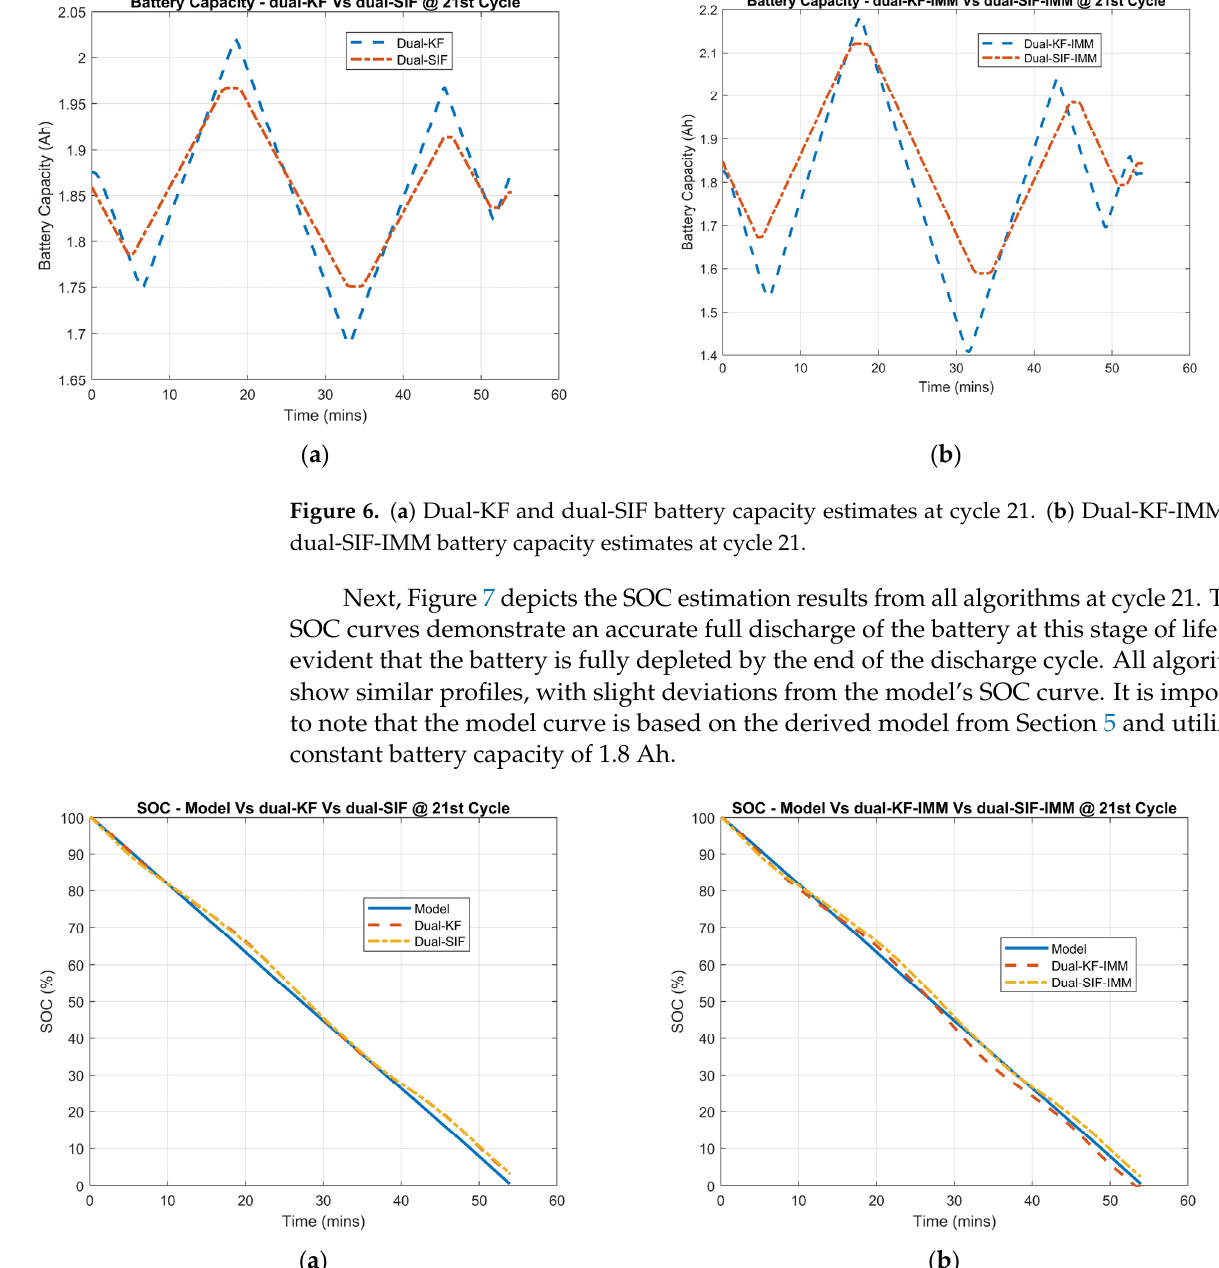
( b ) Figure 8. ( a ) Dual-KF and dual-SIF battery capacity estimates at cycle 445. ( b ) Dual-KF-IMM and dual-SIF-IMM battery capacity estimates at cycle 445.